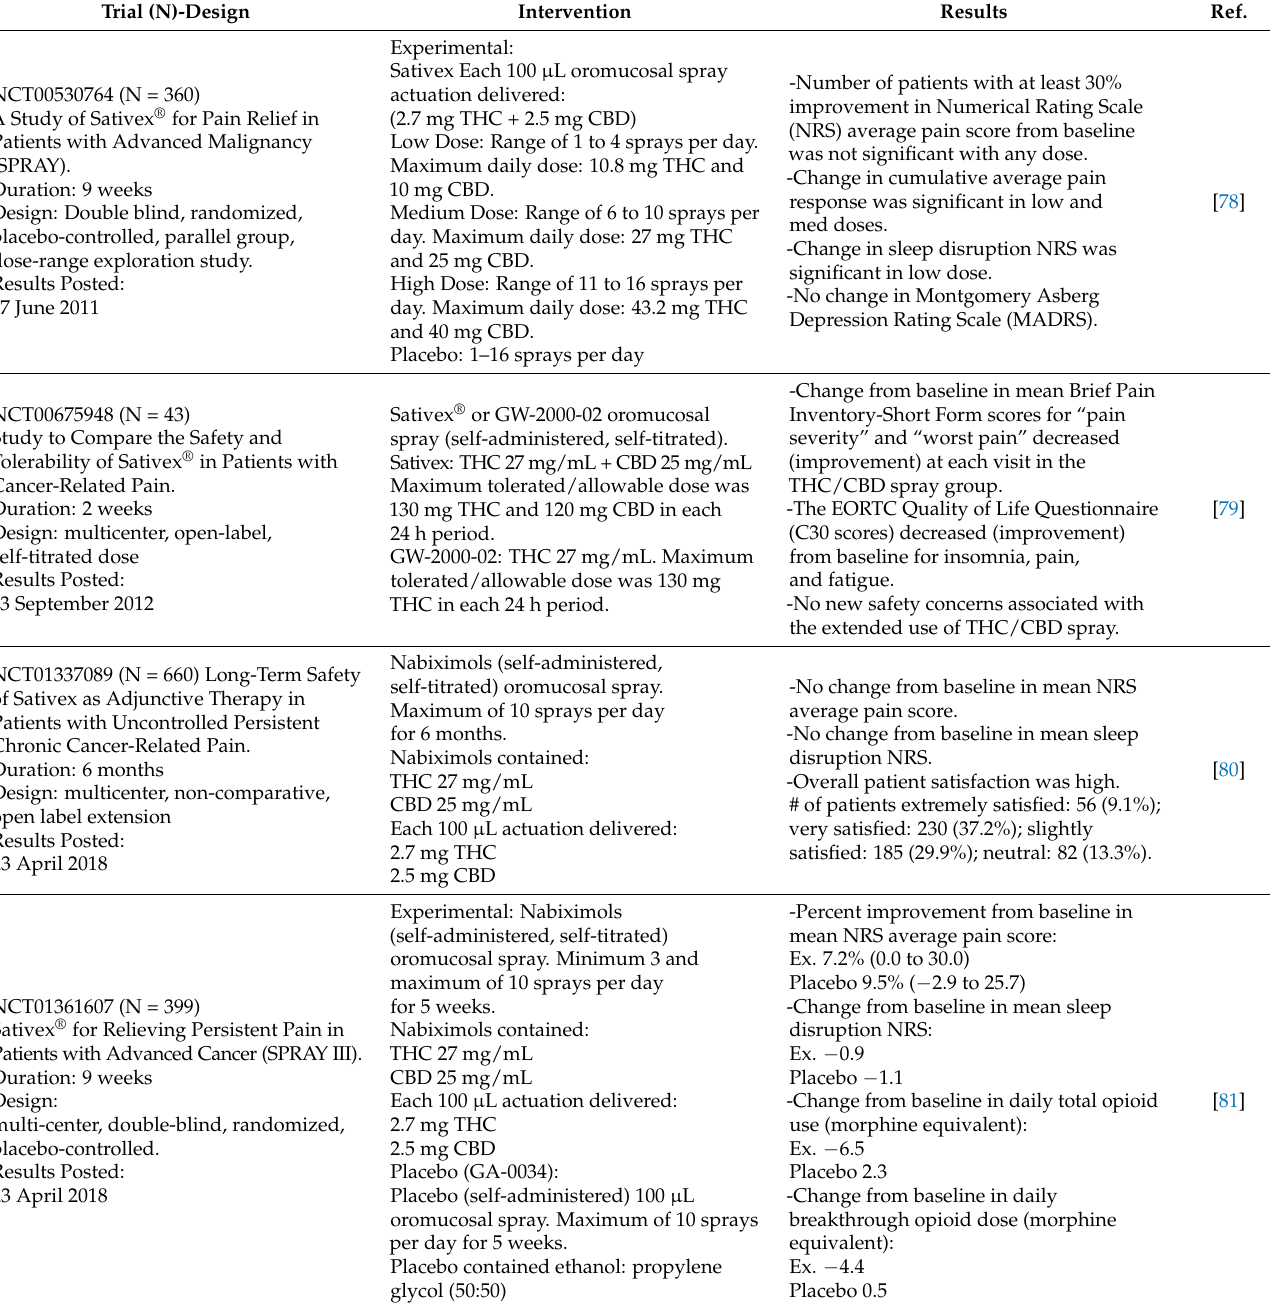
Table 2. Clinical studies of CBD in cancer